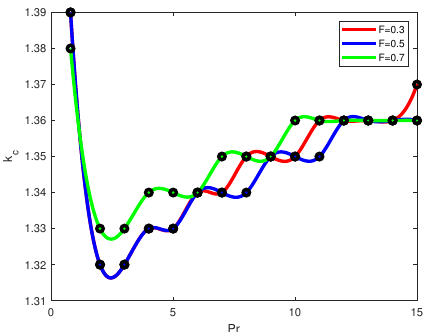
Figure 17. Critical wave numbers versus Pr for Case